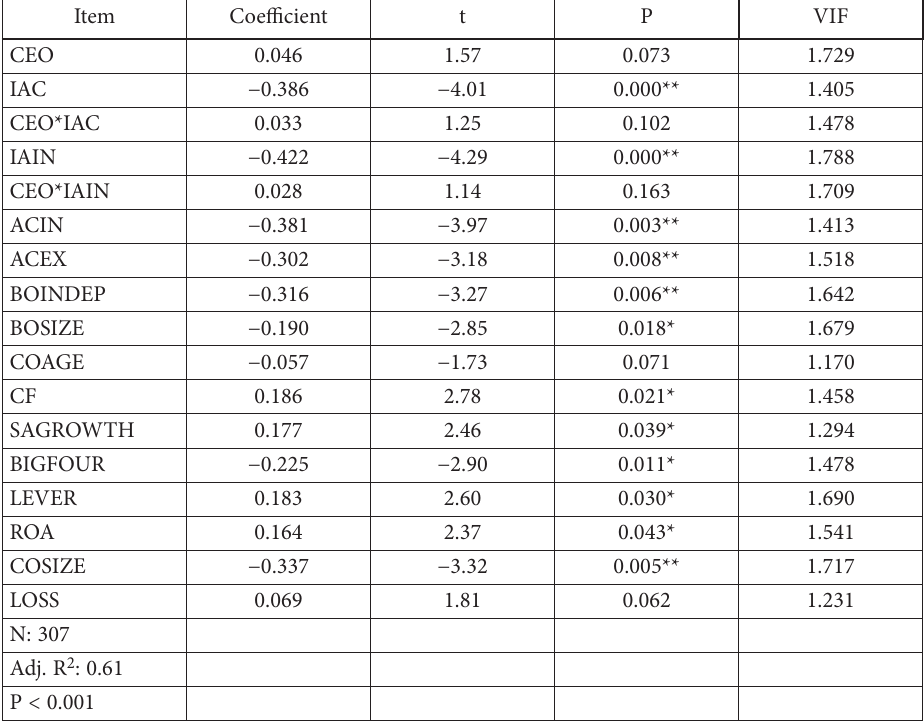
Table 4. Regression results of model 4 −